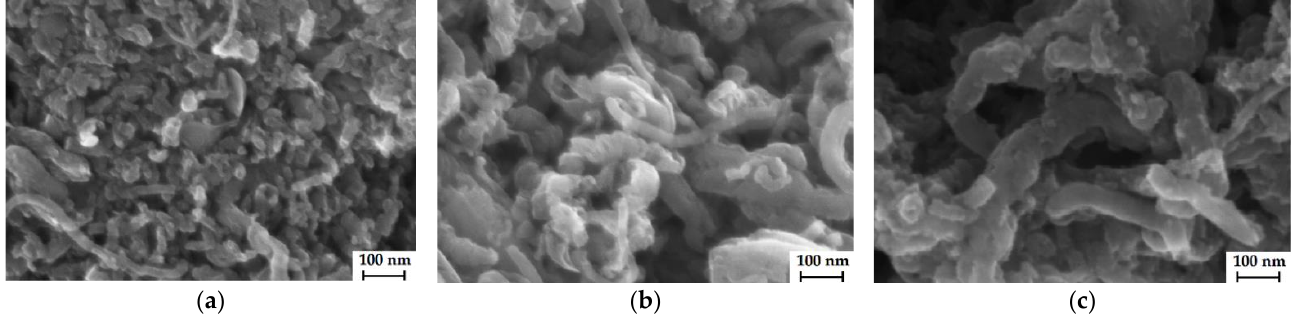
Figure 4. SEM micrographs of the CNTs-COO − ( a ), CNTs-SO 3 − ( b ), and CNTs-NH 3+ ( c ). The IEC values of the dopants were 0.014, 0.27, and 0.64 mmol/g for CNTs-COO − , CNTs-SO 3 − , and CNTs-NH 3+ , respectively. The higher IEC value of CNTs-NH 3+ was due to the additional stage of CNT carboxylation and different mechanisms of interaction. The FTIR analysis of all the types of CNTs confirmed the functionalization (Figure